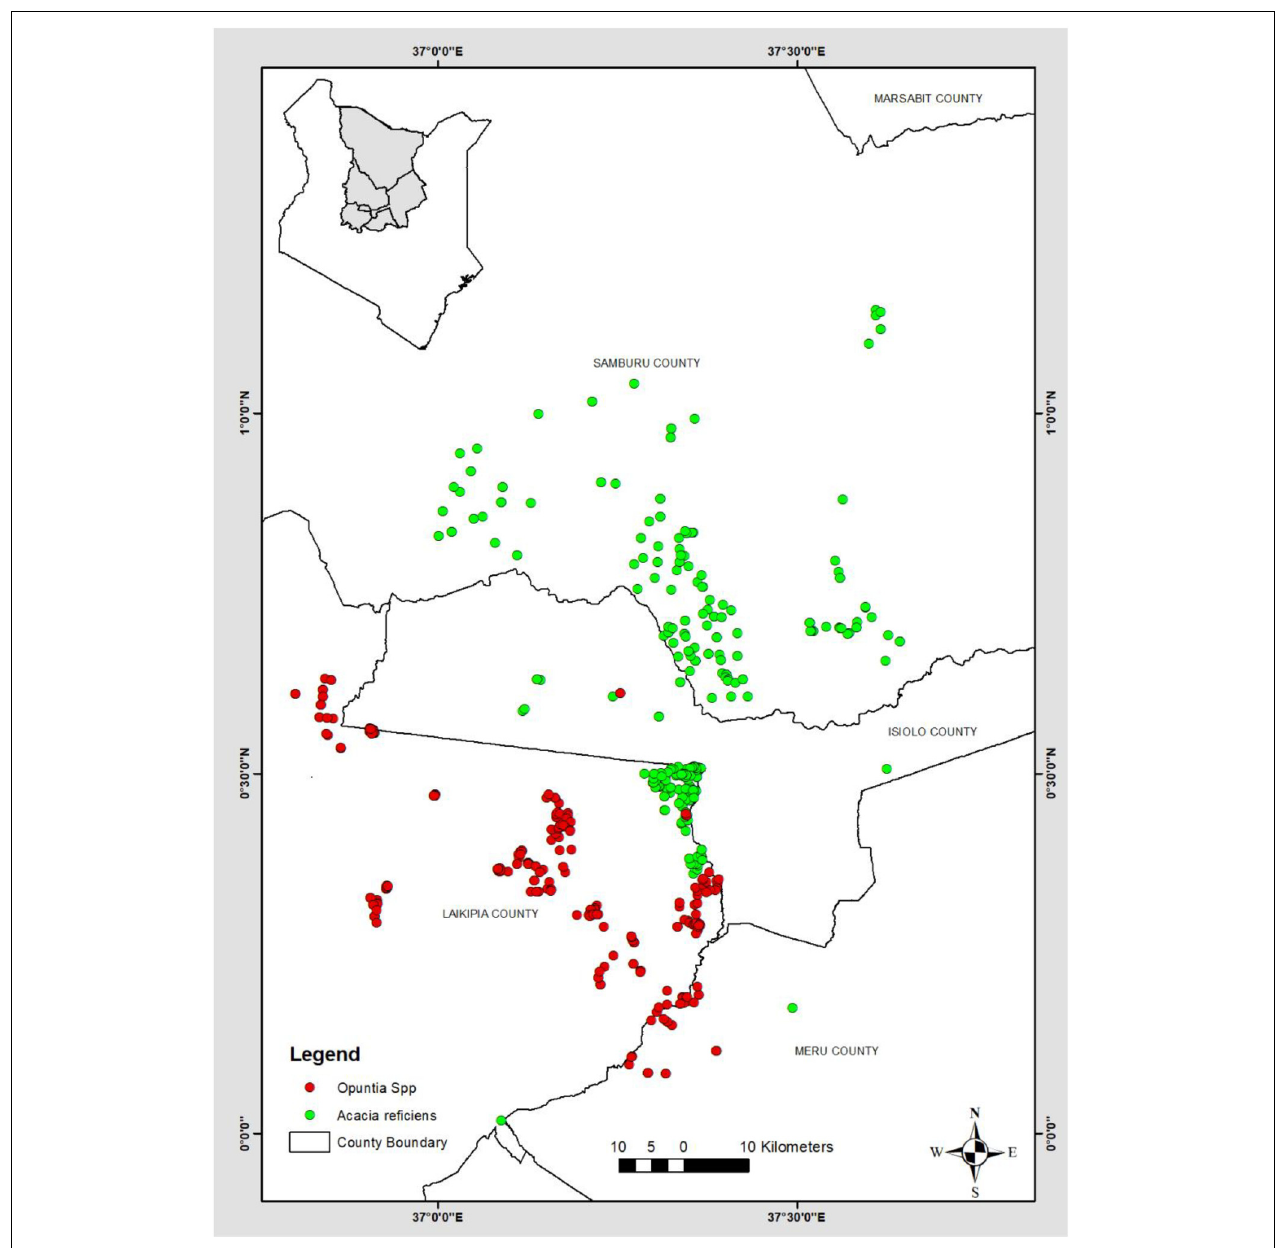
FIGURE 1 | Study area and locations of records used for modeling.